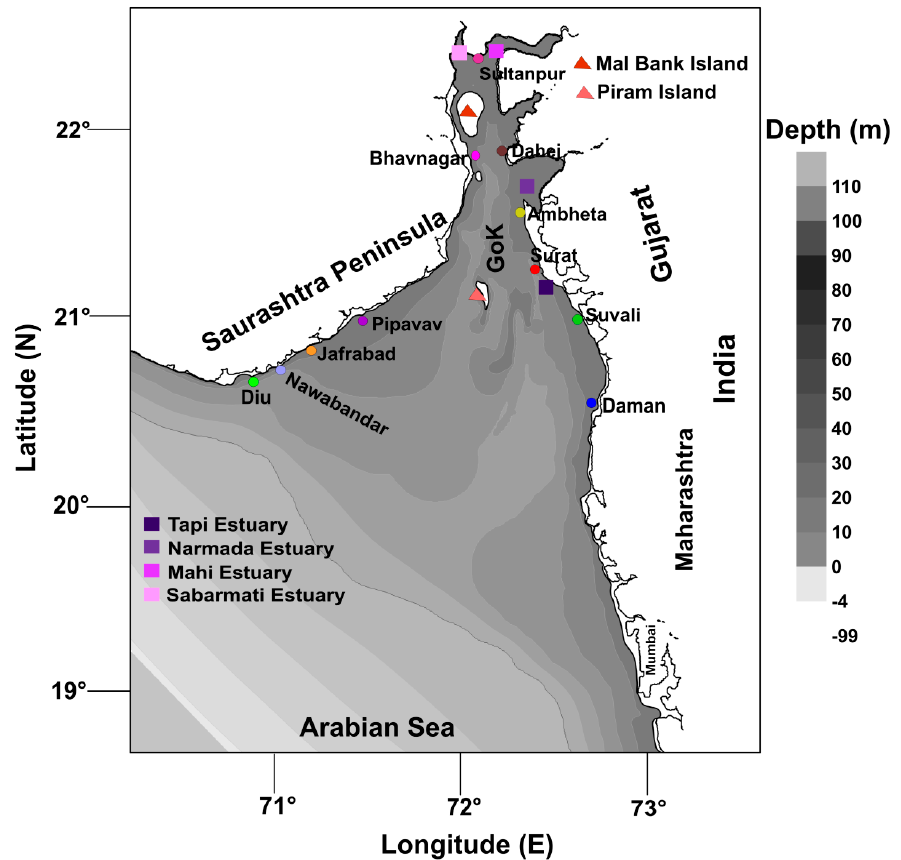
Figure 1. Study area (Gulf of Khambhat and surroundings) showing the bathymetry of the region. Maximum water depth in the model domain is more than 100 m. Total number of grid is 744 × 850 and the grid resolution is 500 m. The model extends towards land up to 4 m above the Chart Datum.